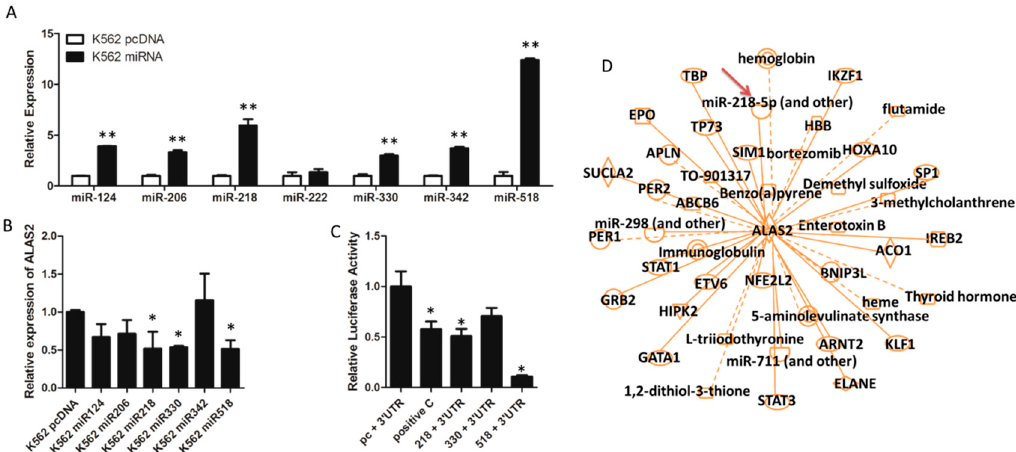
Figure 3. ( A ) Relative mature miRNA expression in K562 control cells and each cell line overexpressing one of the candidate miRNAs using quantitative real-time PCR normalized to snRNA U6 ; ( B ) Relative expression of ALAS2 in control and each miRNA overexpression K562 cells using quantitative real-time PCR normalized to GAPDH ; ( C ) K562 cells were transfected with candidate miRNA (or pcDNA3.0 as control) and the luciferase construct with the ALAS2-3 ′ UTR. After 48 h, relative firefly/renilla luciferase activity in the cells was evaluated. Co-transfection of miR-124 and vimentin ( VIM ) 3 ′ UTR was performed as a positive control [28] as shown in the second column. Asterisks indicate that differences between samples were statistically significant according to an independent-sample t -test, * p < 0.05, ** p < 0.01; ( D ) Functional network of ALAS2 constructed by IPA. miR-218 was listed in the network and highlighted by the red arrow.